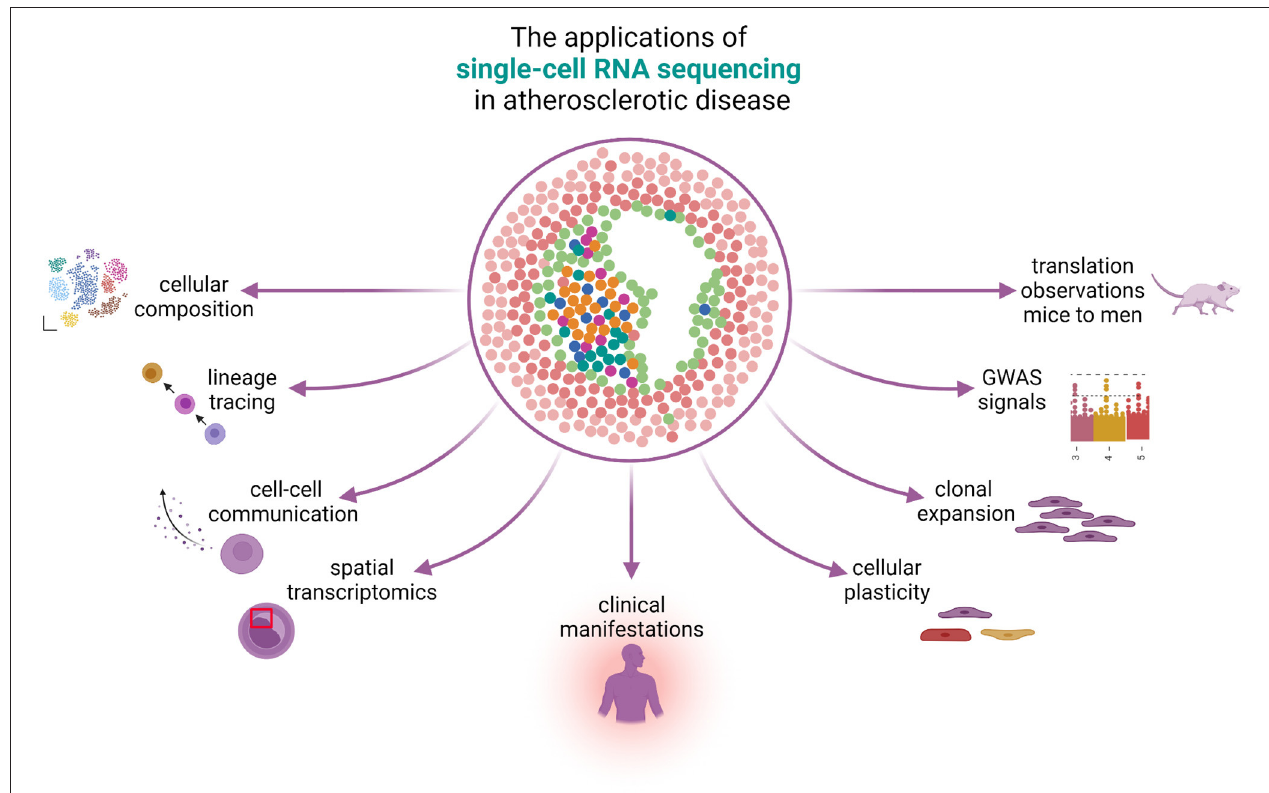
FIGURE 1 | The applications of single-cell RNA sequencing in atherosclerotic disease. scRNA-seq can be used to study many different aspects of atherosclerotic disease. The knowledge on cellular composition can give insights on lineage tracing and can be used to study cellular plasticity, clonal expansion, and reveal cell-gene pairs from GWAS signals. Spatial transcriptomics reveals the physical locations of different cell populations in the plaque and can additionally be used to study cell-cell communication. scRNA-seq can reveal differences in cells under the influence of different clinical presentations and bridge the gap between mice and men.